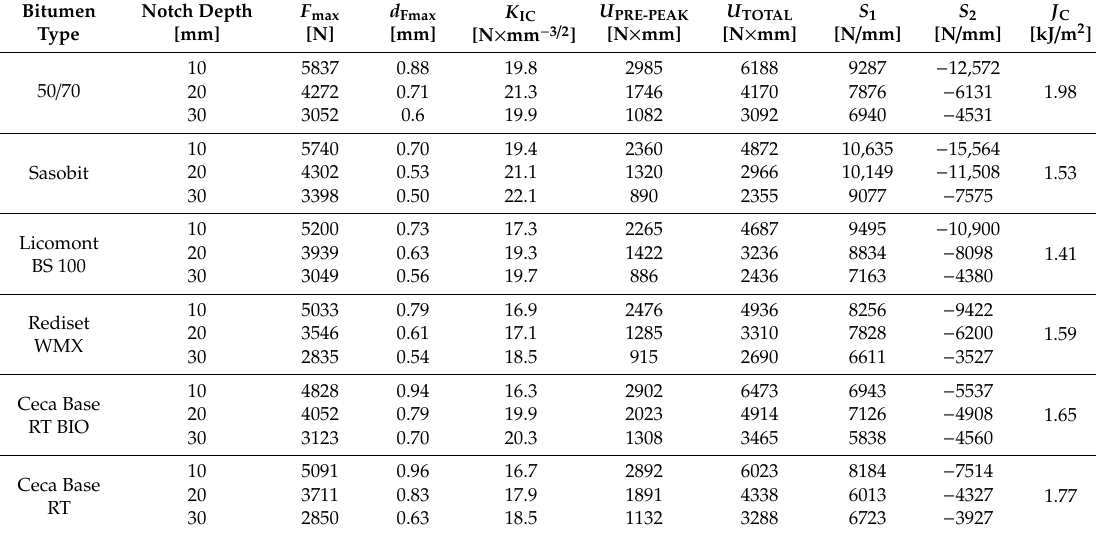
Table 6. SCB test results at − 20 ◦